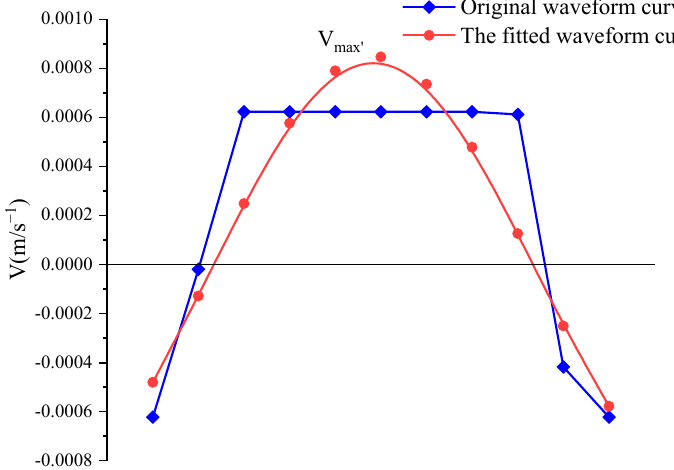
Figure 7. Waveform fitting diagram.